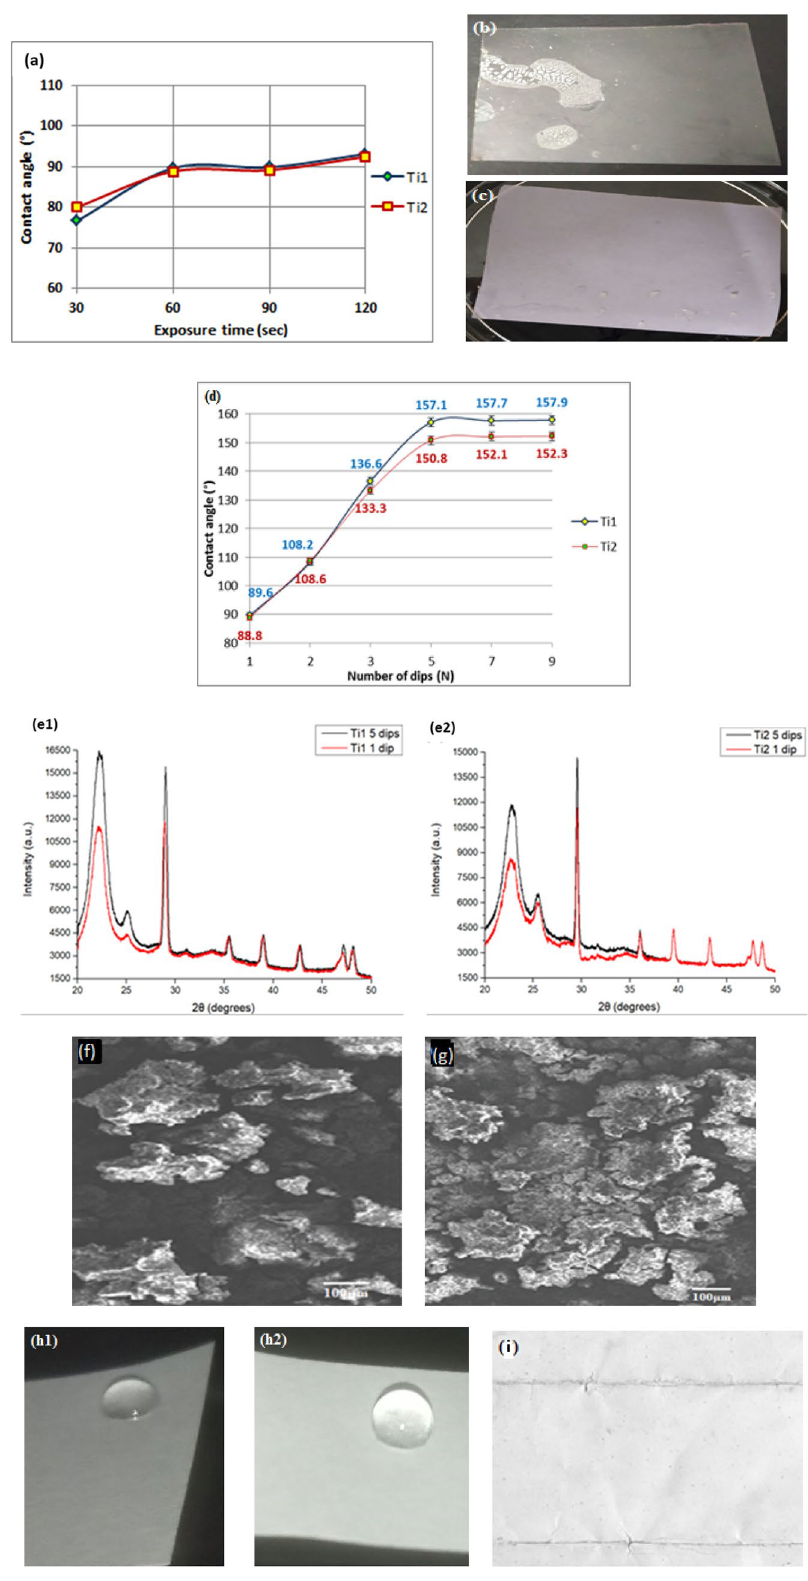
Figure 4. ( a ) Contact angle measurements at 30, 60, 90 and 120 secs for TMMS and TEOS dipped paper; ( b ) asperities on dried paper surface after 2 coats for 90 s dip coats, ( c ) surface asperities on 120 secs dipped paper after drying; ( d ) Number of dips versus the contact angle for Ti1 and Ti2 solutions; ( e1,e2 ) XRD intensity curves for paper dipped once and 5 times in Ti1 and Ti2 respectively (Pan Analytical X’pert Powder Diffractometer/ X’Pert Highscore software); ( f,g ) SEM images of Ti2 coated surface after 1 dip and 5 dips respectively (EVO 50 (CARL Zeiss) system); ( h1 , h2 ) water droplet on paper dipped once and 2 times for 60 secs; ( i ) 9 times dip coated paper stiffening and showing wrinkles when